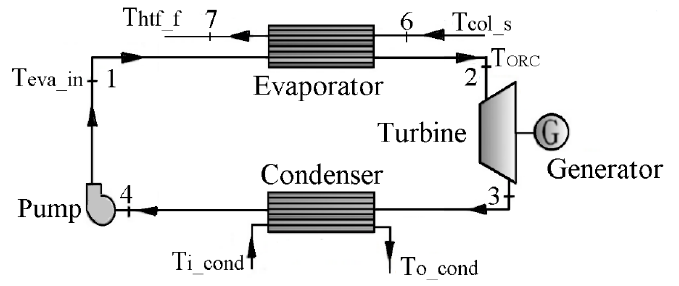
Figure 4. Organic Rankine Cycle configuration.